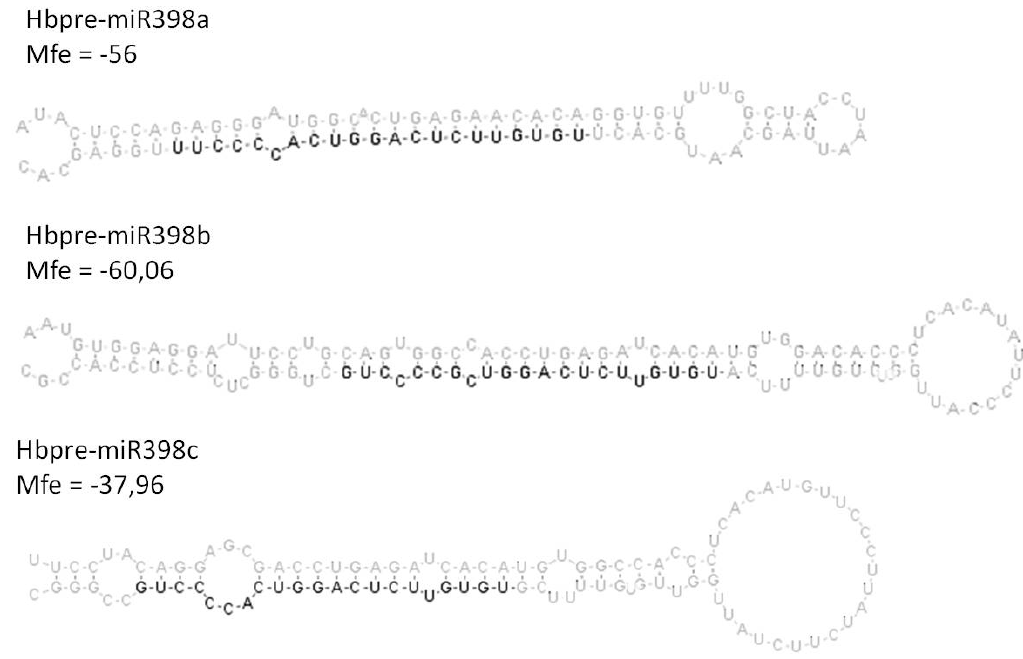
Figure 2. Stem-loop structure of three precursors of MIR398 in Hevea brasiliensis . The mature microRNA sequence is shown in dark.